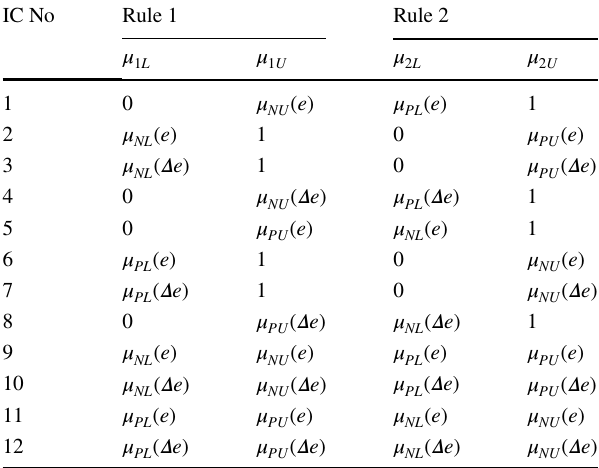
Table 1 Resultant membership functions in the input plane